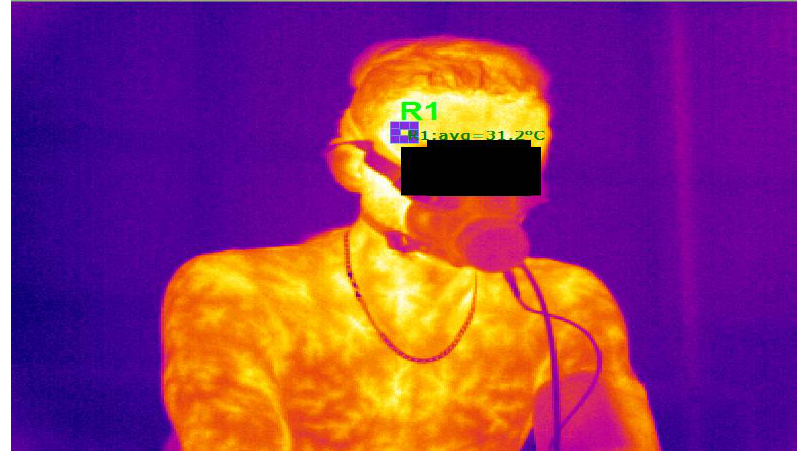
Figure 2. Single frame of film recorded during a test at 110%Pmax in which the field (R1) for temporal surface temperature analysis is marked.